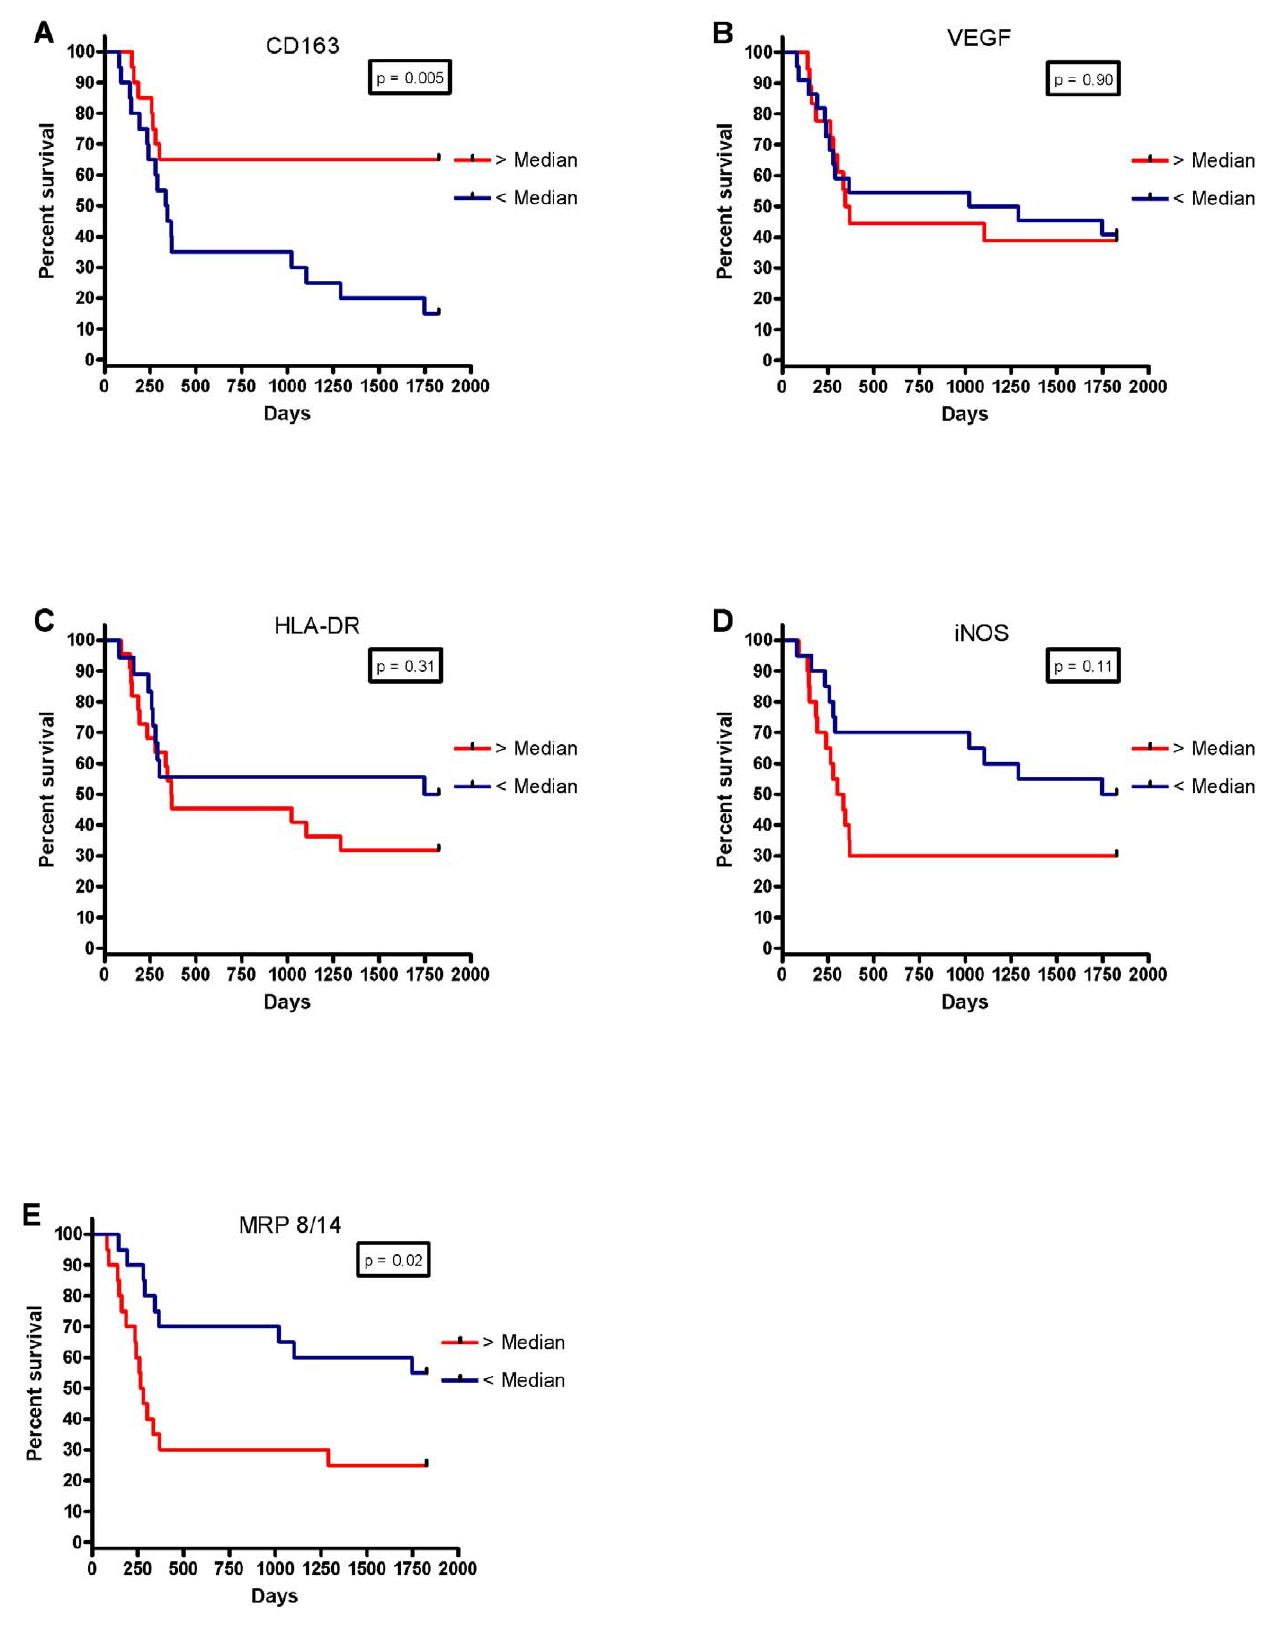
Figure 5. Kaplan-Meier five year survival curves for non-macrophage densities in the tumour stroma for (A) CD163, (B) VEGF, (C) HLA-DR, (D) iNOS and (E) MRP 8/14.